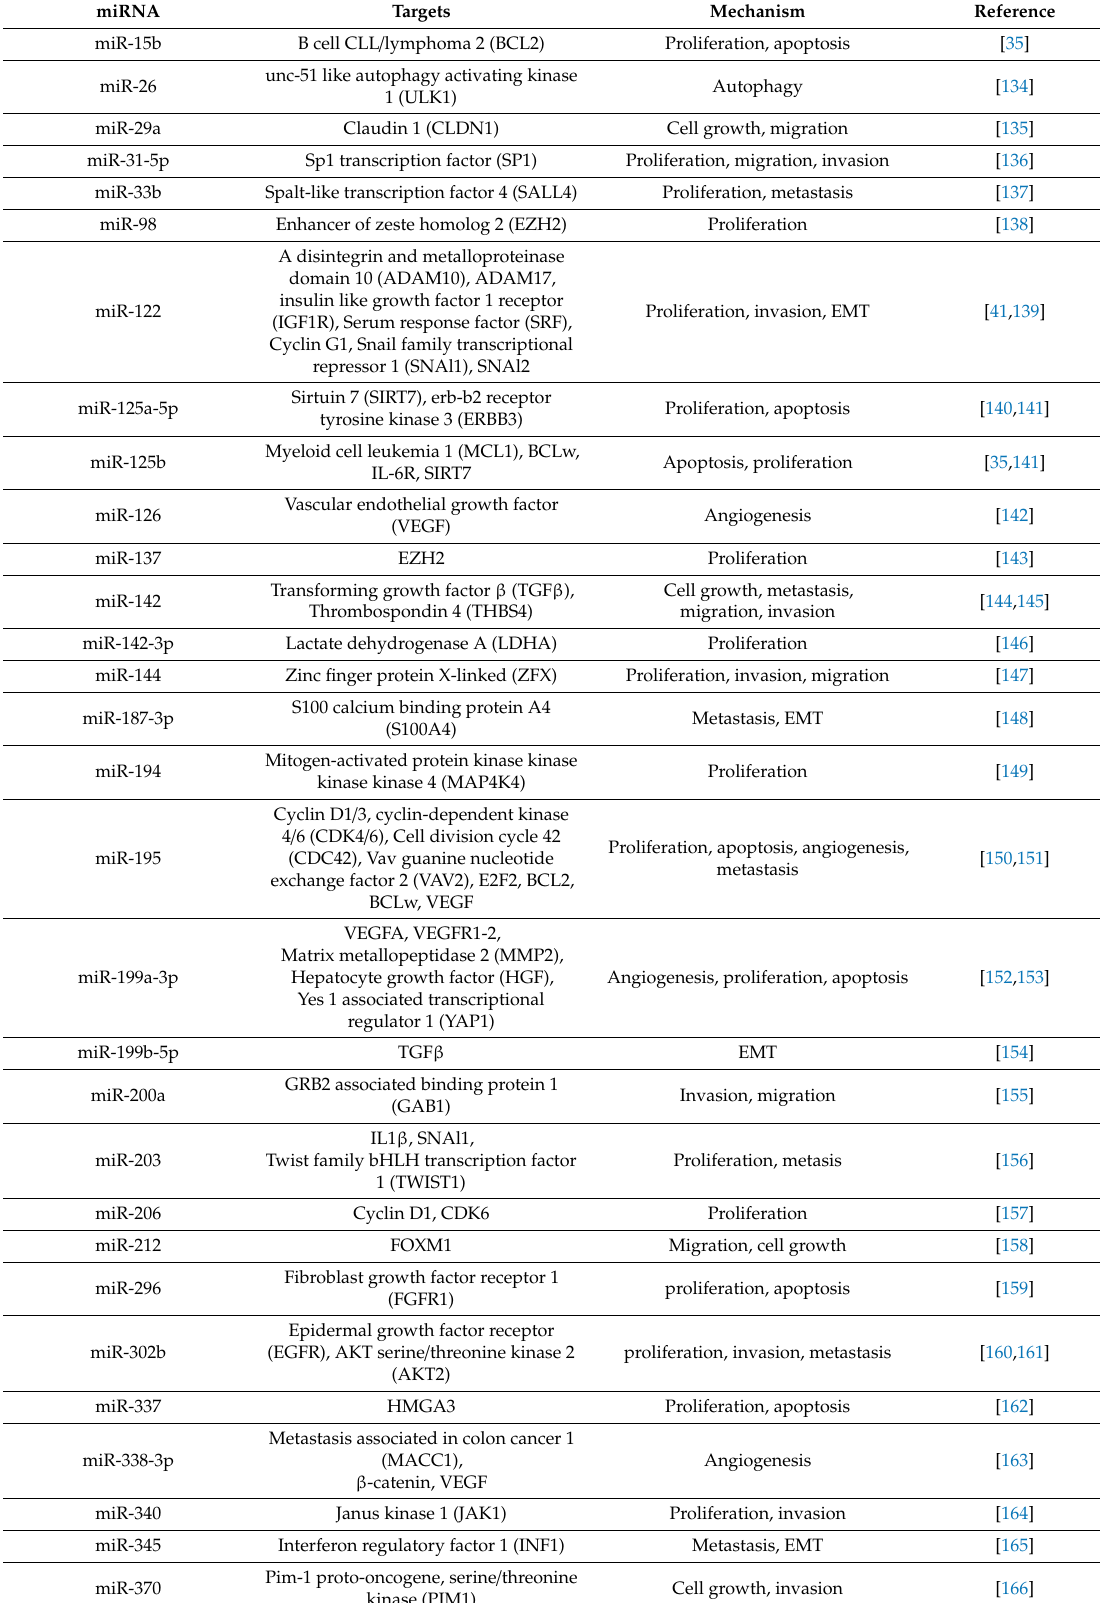
Table 3. Recently reported downregulated miRNAs acting as tumor suppressors in HCC.